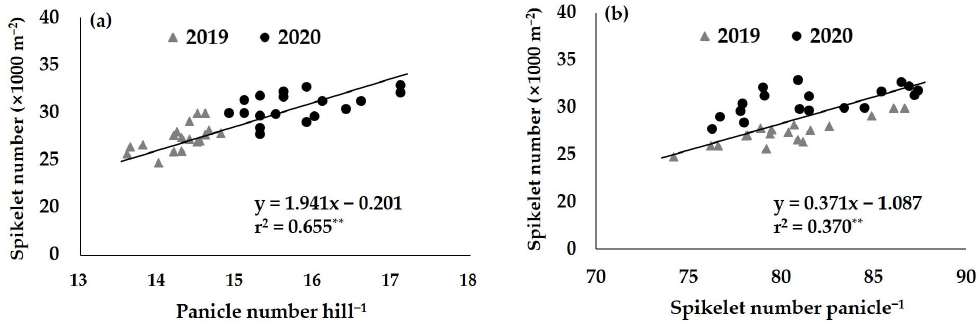
Figure 7. Relationship between spikelet number m − 2 and ( a ) panicle number hill − 1 and ( b ) spikelet number panicle − 1 . **: signi fi cant at p < 0.01.